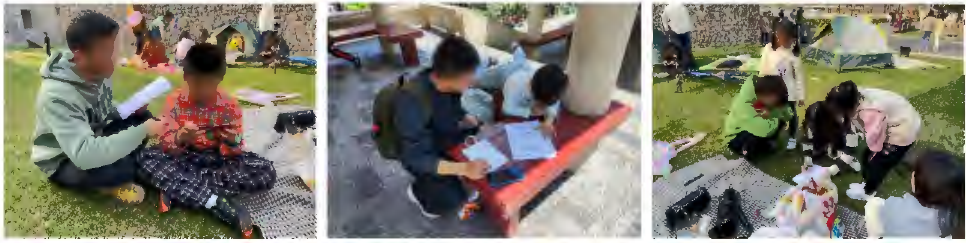
Figure 2. Picture of